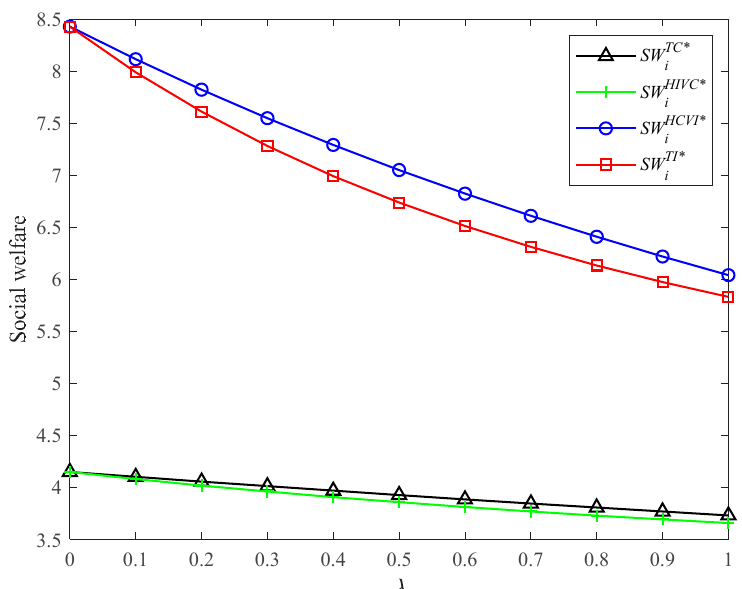
Figure 7. Social welfare in four models with different λ .